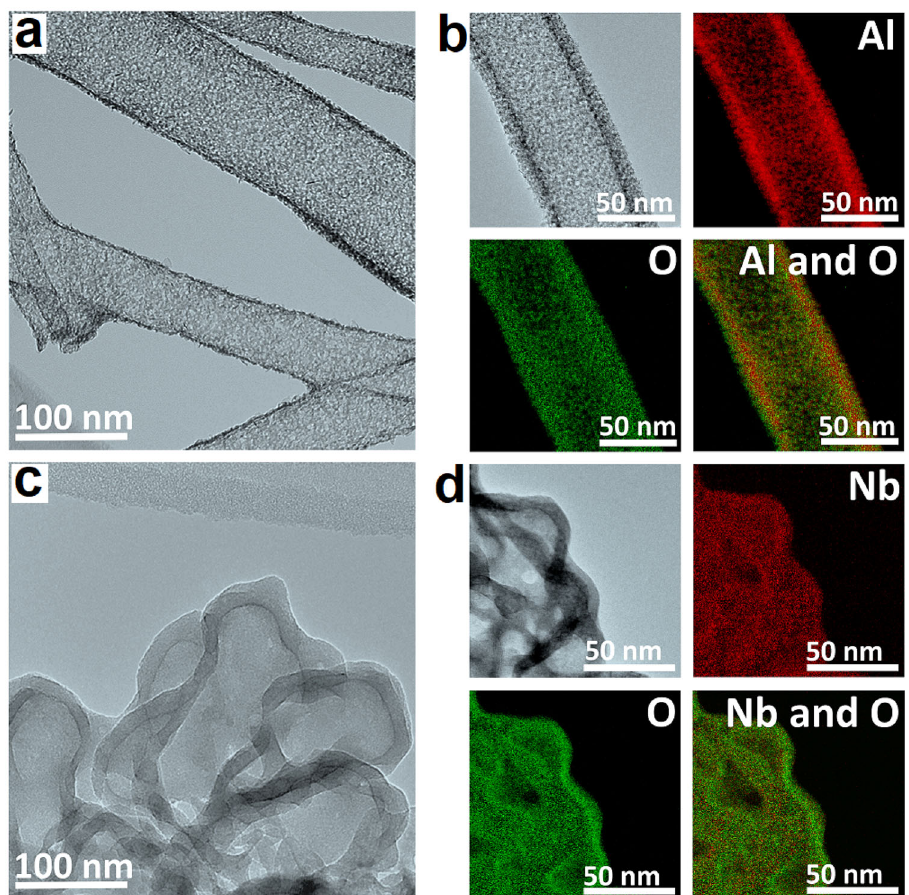
Fig. 4 Metal oxide nanotubes and nanoshells made from nanocoatings. a A TEM image of Al 2 O 3 nanotubes made from burning off the CNTs in air in TEM image shows Nb 2 O 5 nanoshells made from burning off the carbon inside niobia-coated carbon black. d EFTEM elemental mapping of the nanoshells showing elements of Nb and